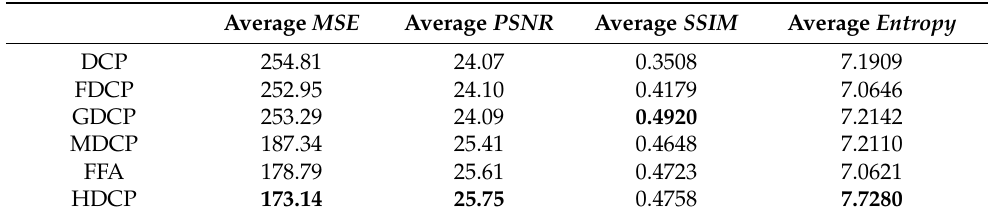
Table 5. Comparison of the overall objective evaluation results of different algorithms on the en- hancement of the O-HAZE dataset.